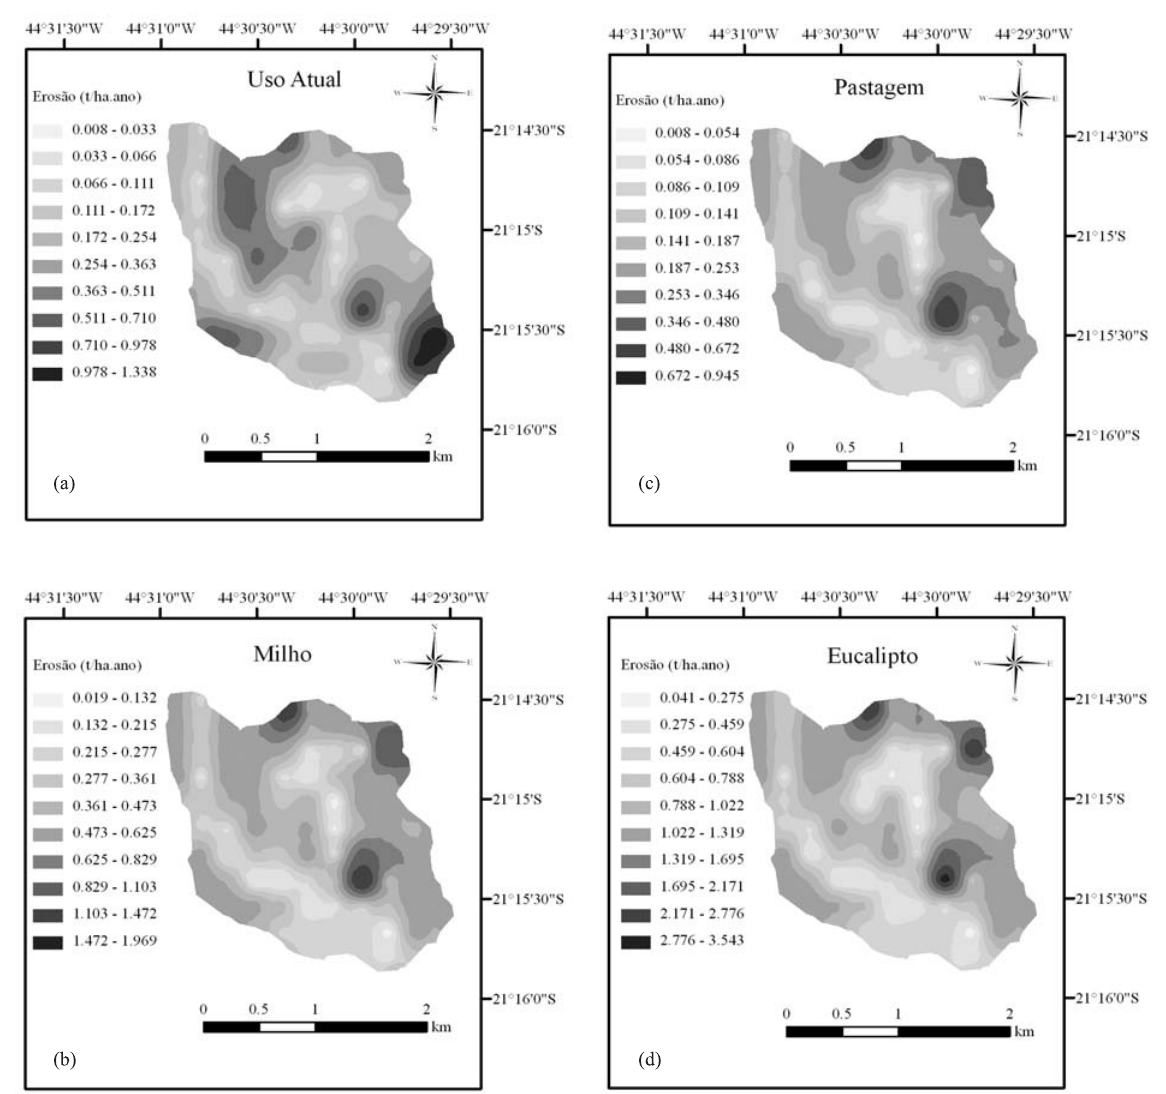
Figura 3. Simulação da distribuição espacial da erosão do solo, em t ha -1 ano -1 , para os cenários trabalhados na sub-bacia hidrográfica do Ribeirão